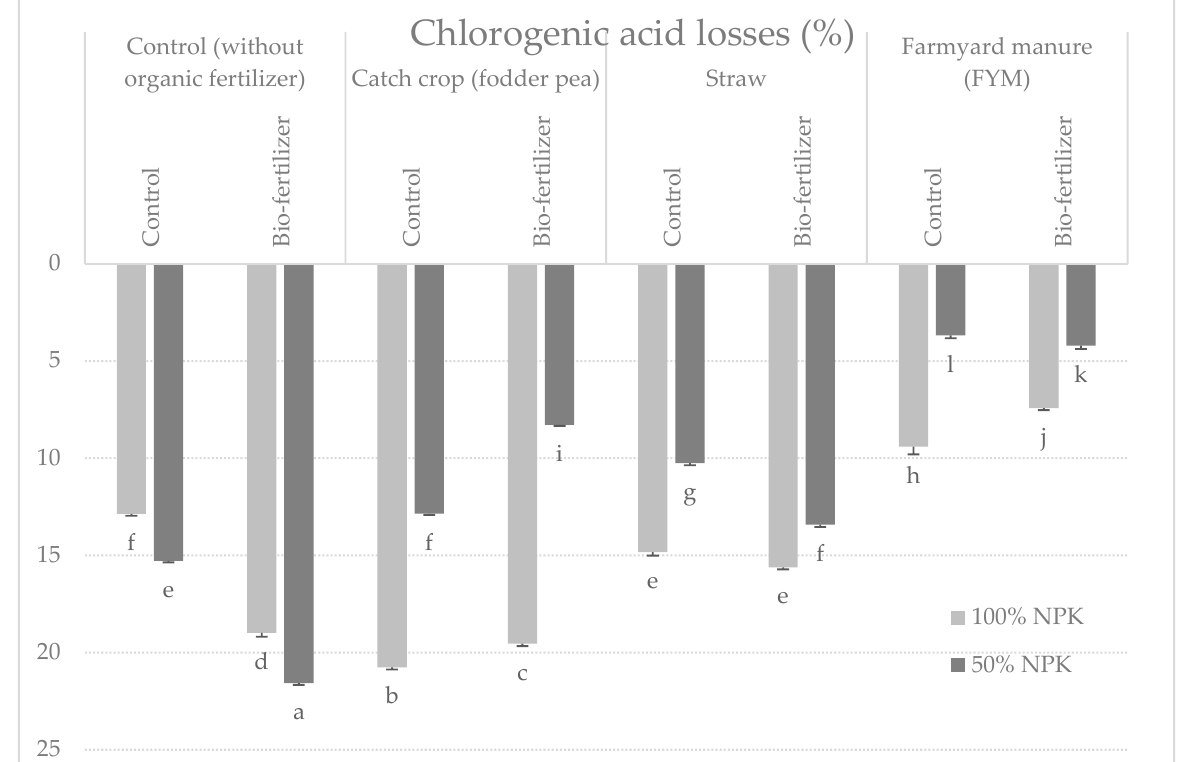
Figure 3. Percentage changes in chlorogenic acid content in potato tubers after 6 months of storage depending on the tested factors (mean from 3 years storage seasons). a, b, c, d…: means noted with the same letter are not significantly different ( p < 0.05).